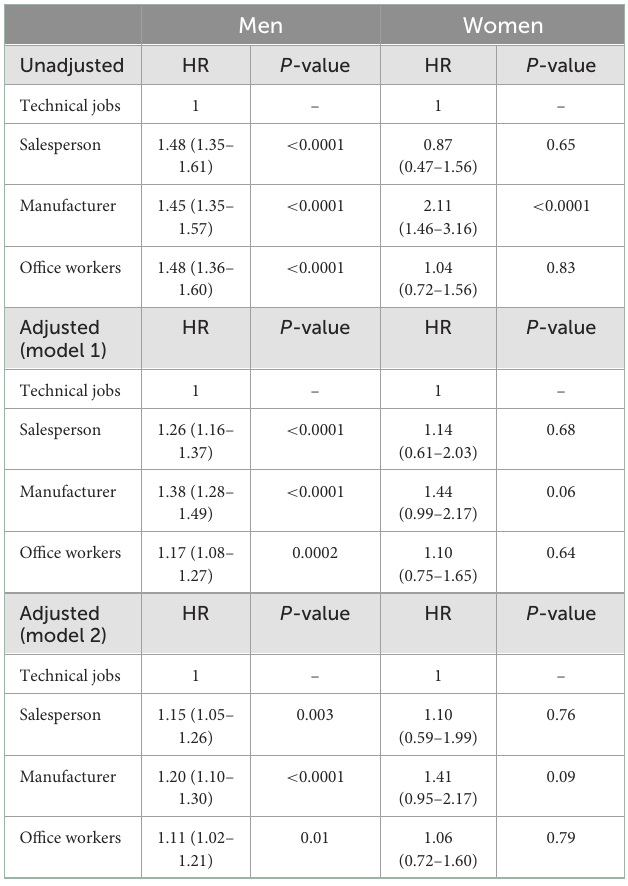
TABLE 4 Unadjusted and adjusted hazard ratios (95% CI) for development of diabetes according to occupation